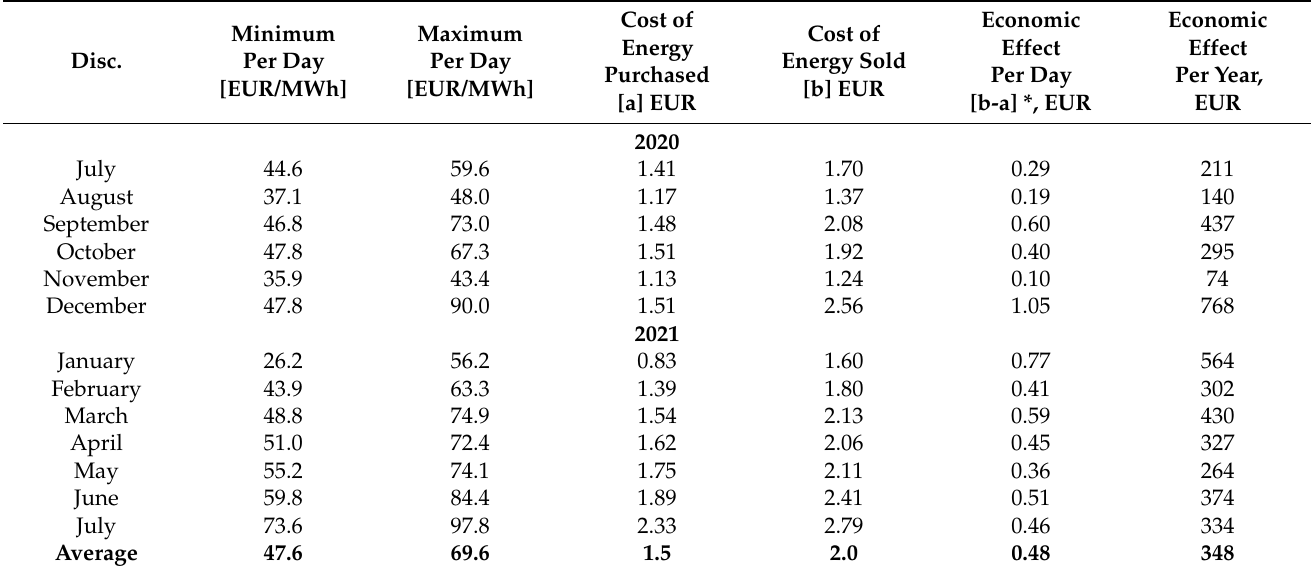
Table 4. Analysis of storing energy in the shaft.